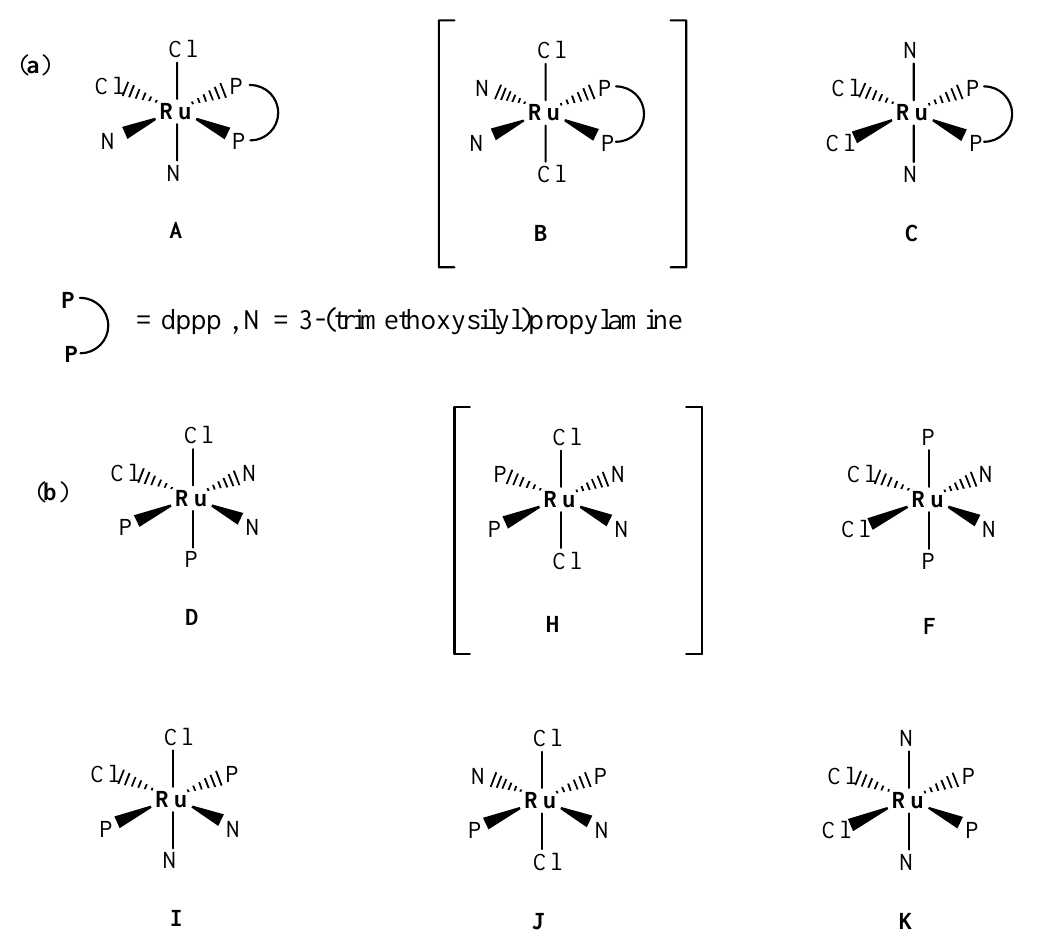
(P) (N) formula, where P-donor is monodentate 2 2 2 or 3